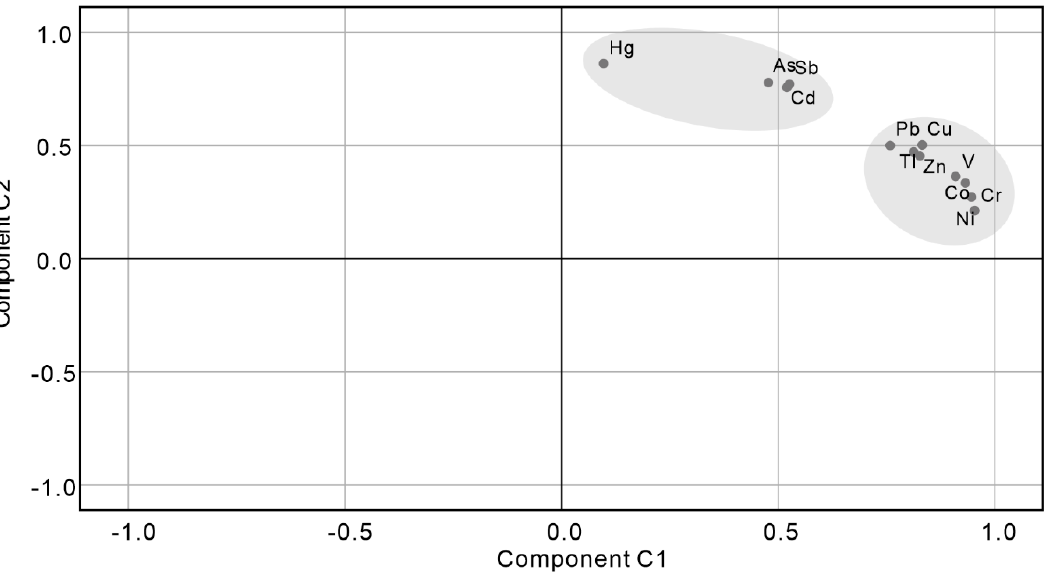
Figure 2. The component-loading plot of the potentially toxic elements, which indicates the potential influencing factors.